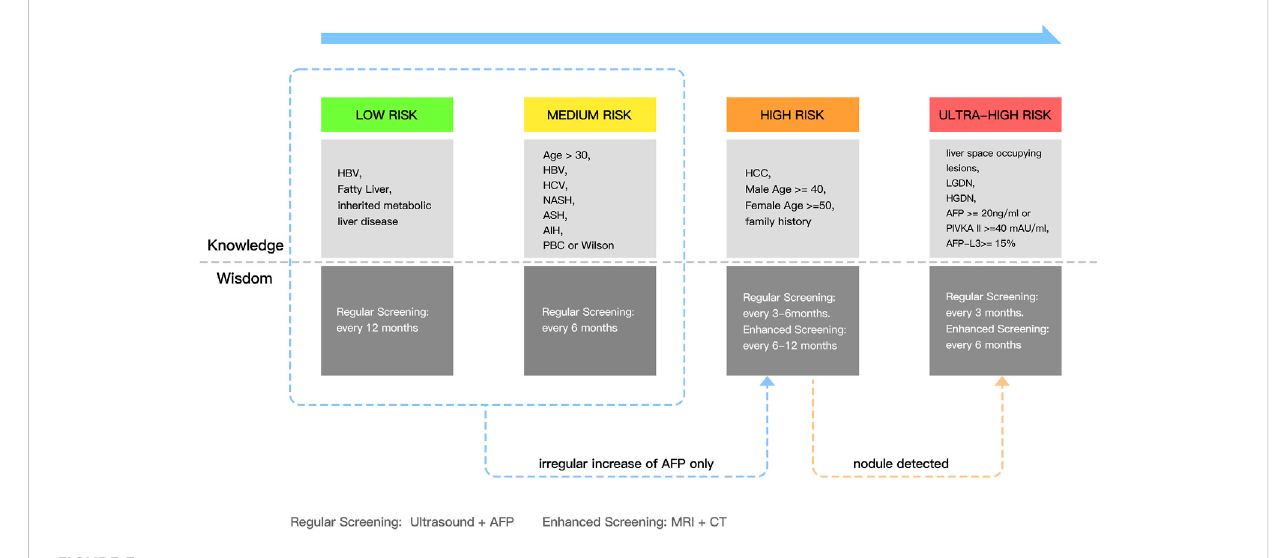
FIGURE 3 The overview of knowledge and wisdom in the diagnosis of HCC.